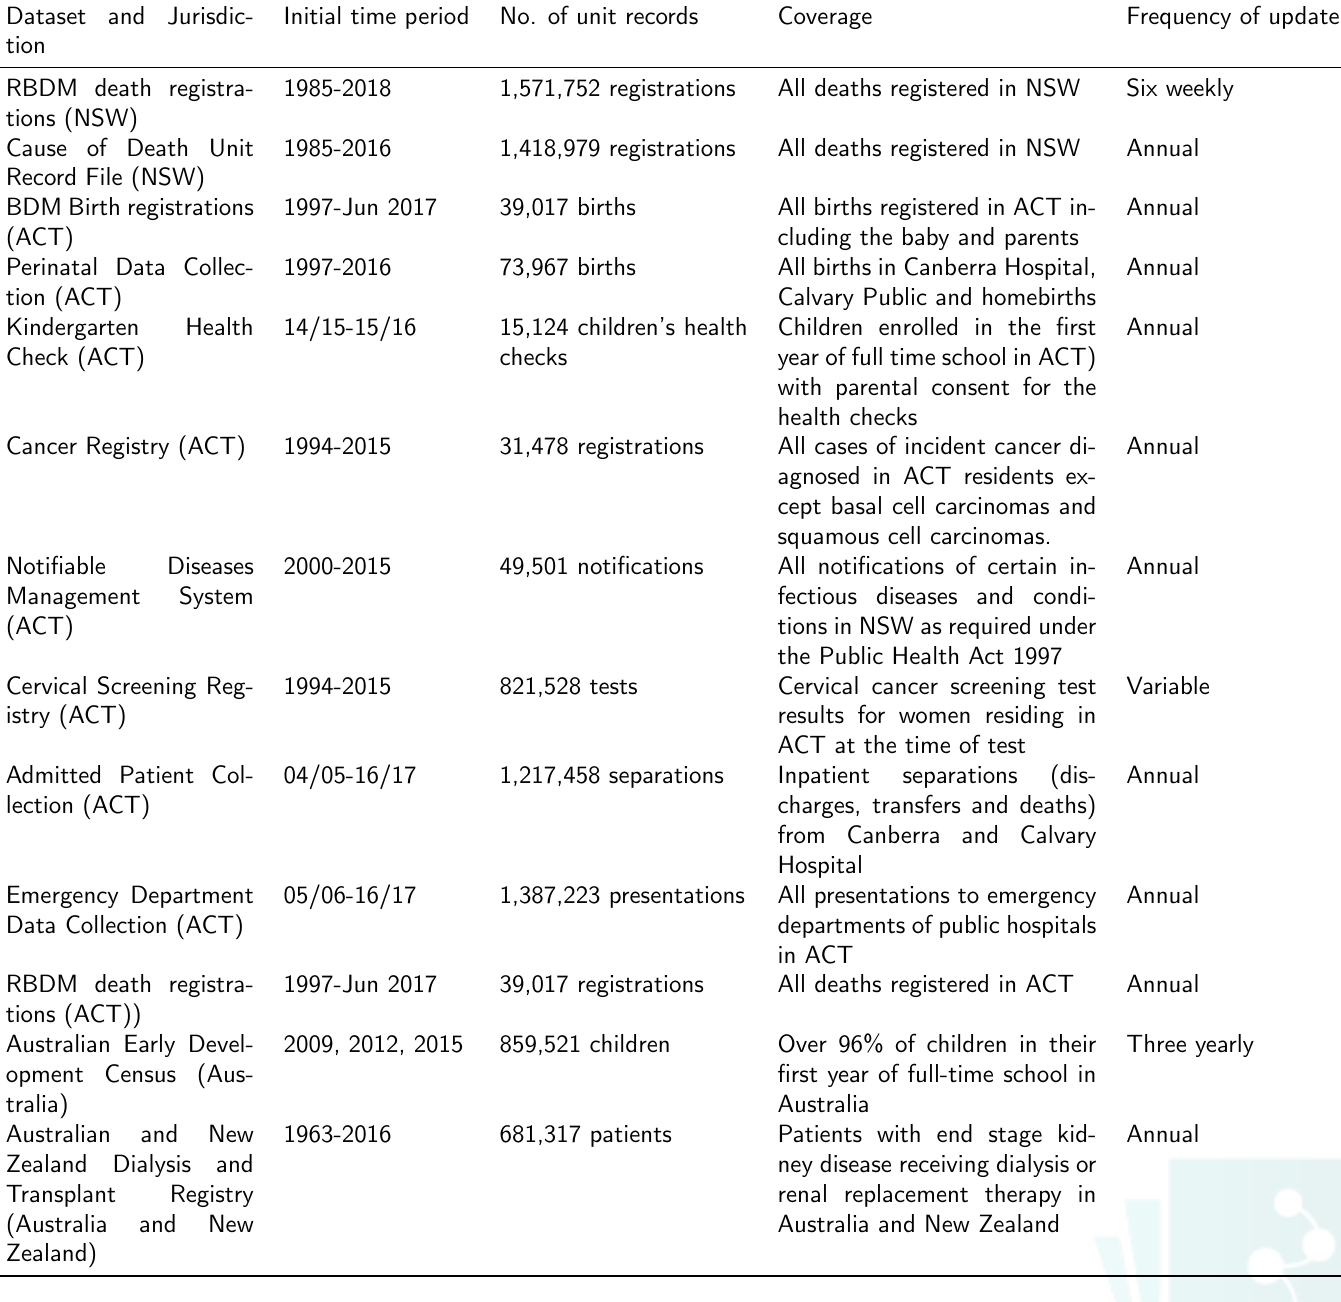
Table 1 Cont.: Characteristics of data included in the CHeReL Master Linkage Key at April